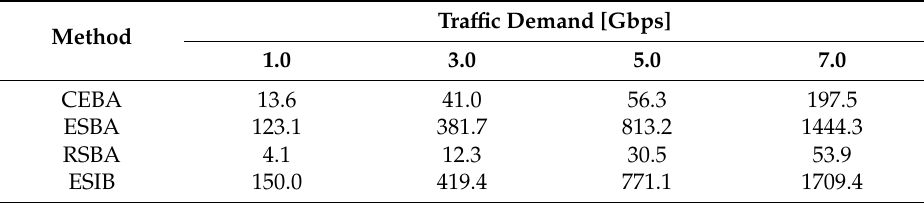
Table 2. Measured simulation time in minutes for the